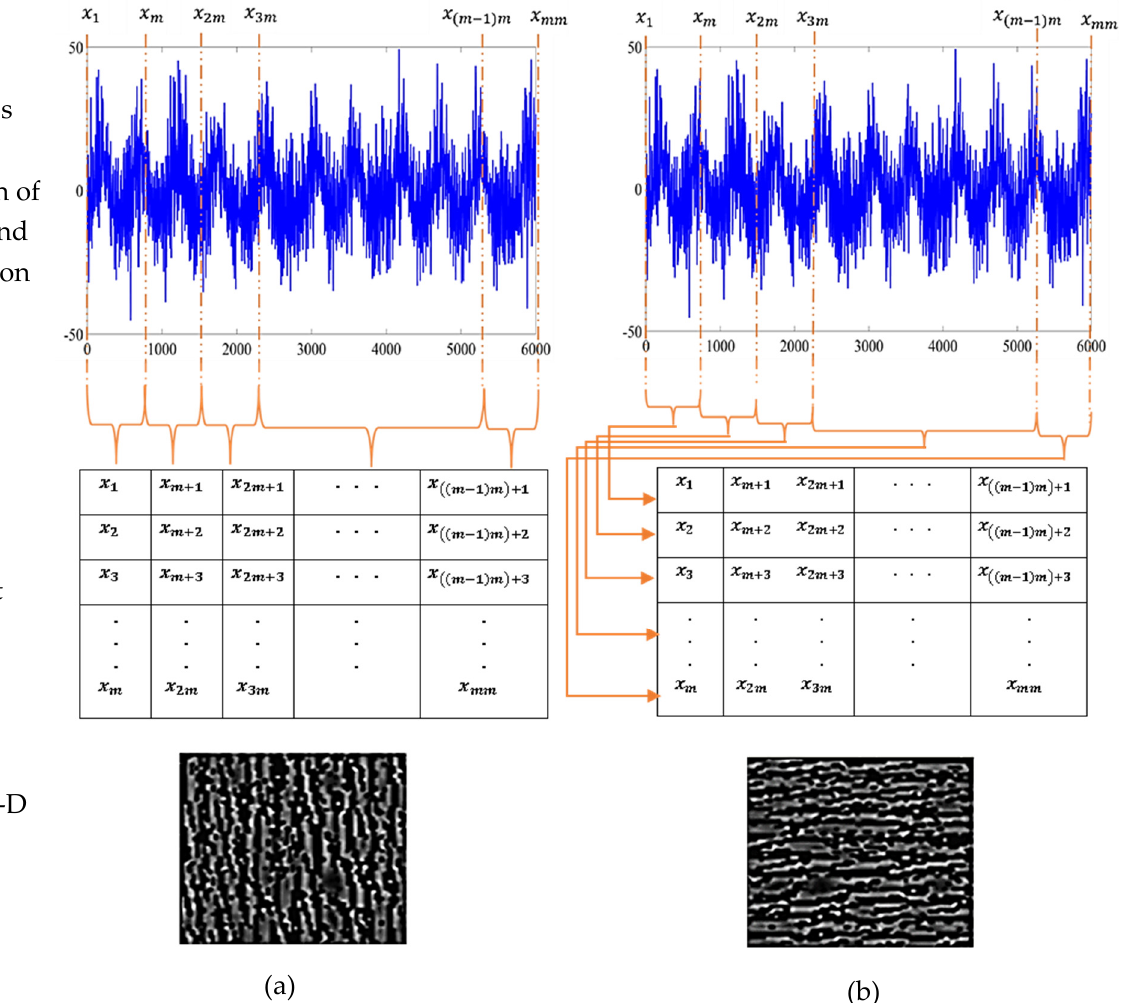
Figure 3. Conversion of a 1D vibration signal to a 2D vibration image based on ( a ) aligning each segment as a column and ( b ) aligning each segment as a row.